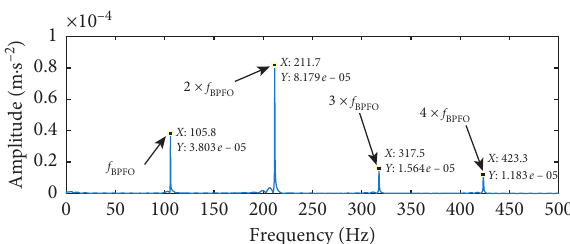
Figure 16: Simulated frequency domain signal for a localized fault which is 0.014 inches and the speed is 1772rpm.